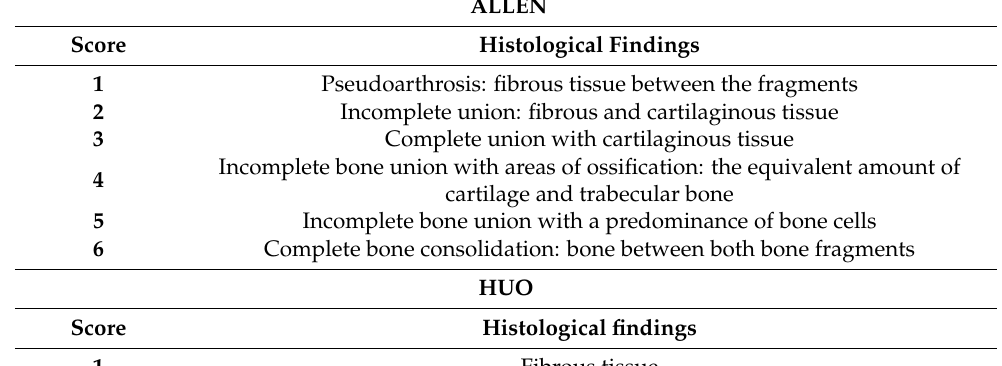
Table 1. Histological scores. Allen score, Huo score and Bone Bridge score to assess histological consolidation. ALLEN Score Histological Findings Pseudoarthrosis: fibrous tissue between the